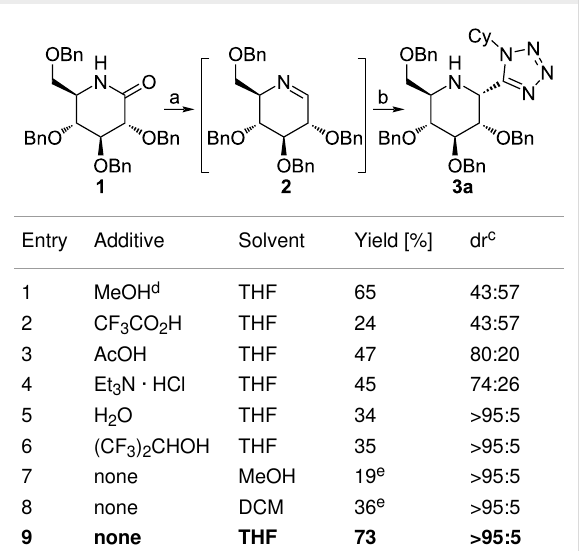
Table 1: Optimization of 2-(1 H -tetrazol-5-yl)-iminosugar synthesis via Schwartz’s reagent-mediated reduction of amides and Ugi–azide reac-